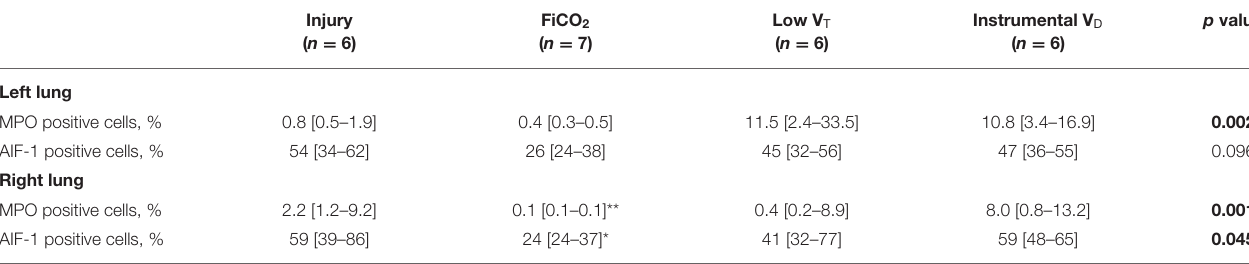
TABLE 1 | Characterization by immunohistochemistry of the lung immune cell infiltrates in the different